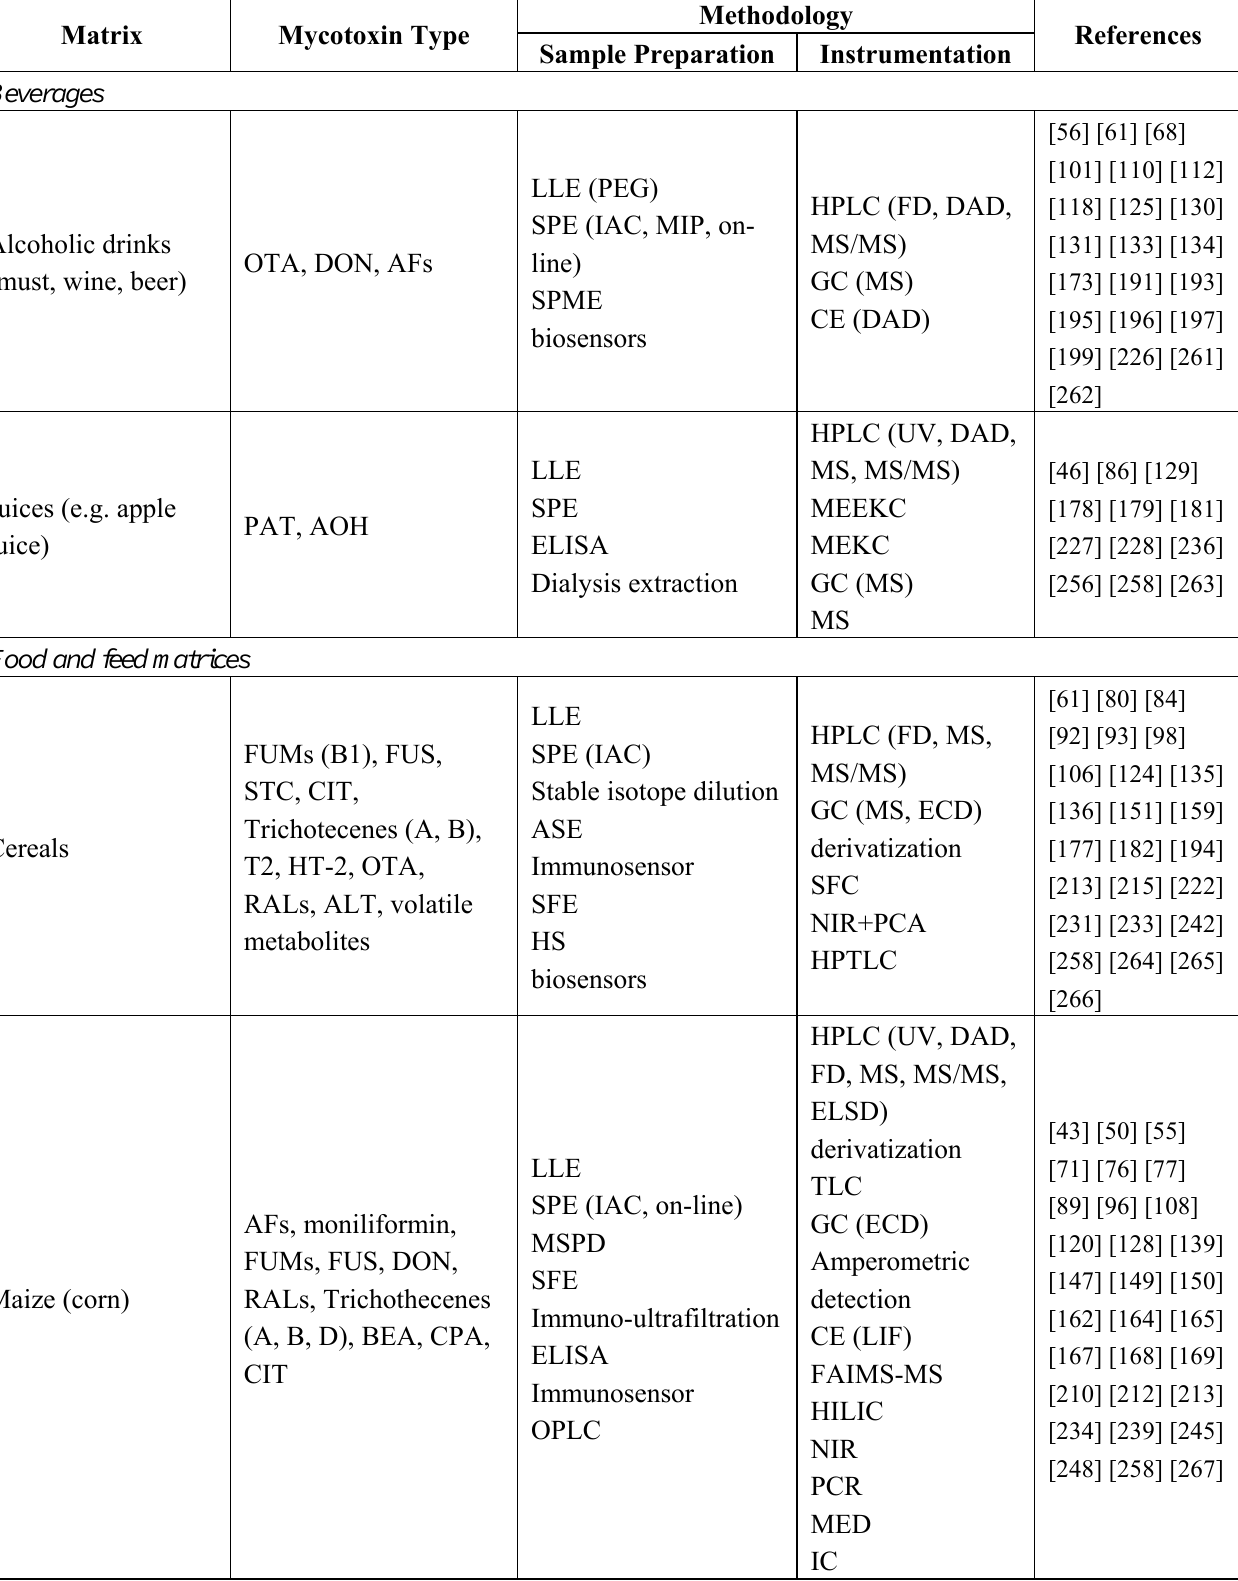
Table 2. Methodology for determination of mycotoxins in different